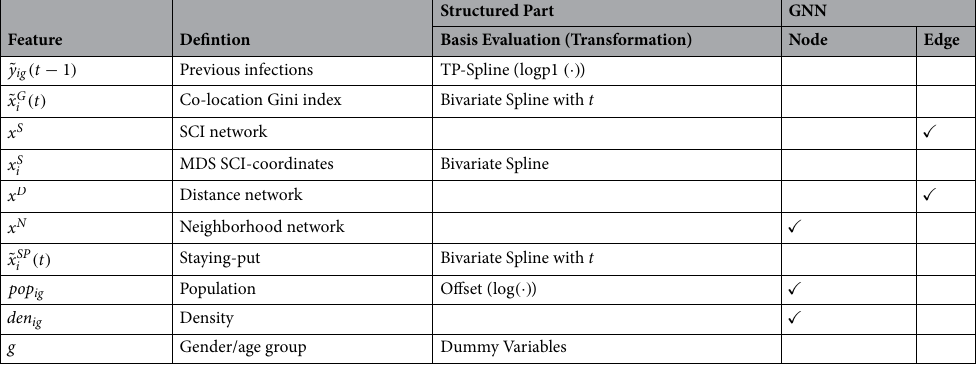
str where ˆ I is the Hessian of the negative log-likelihood at the estimated network parameters ˆ ϑ 44 . We note that still allows us to get a feeling for the network’s uncertainty. Deep ensembles 68 are a simple method that provides reliable uncertainty estimates, and are used to account